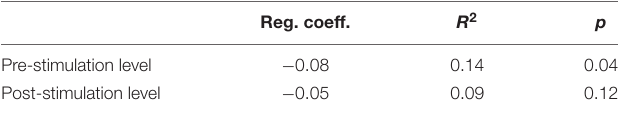
TABLE 4 | Regression coefficients for HR levels (linear regression model was used).